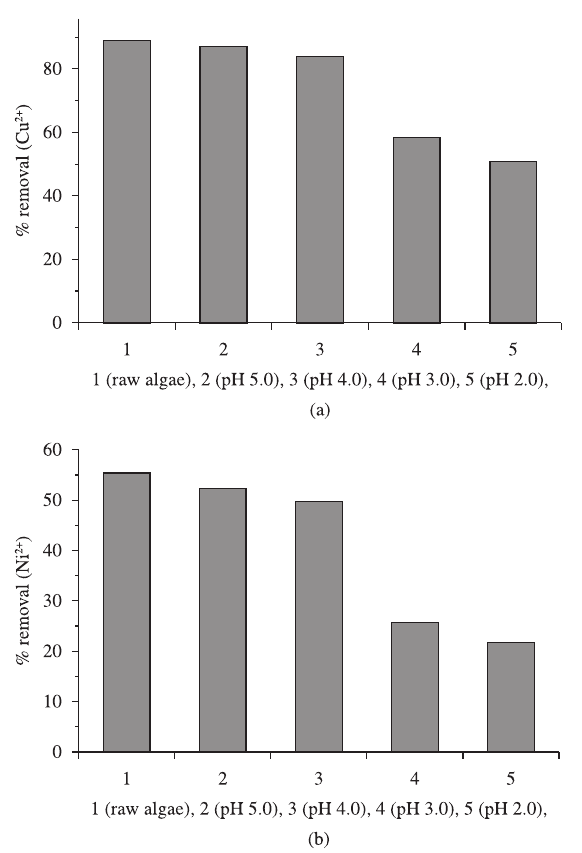
Figure 3. Comparison of a) %Cu 2+ removal; and b) %Ni 2+ removal of raw and acidified Sargassum filipendula .